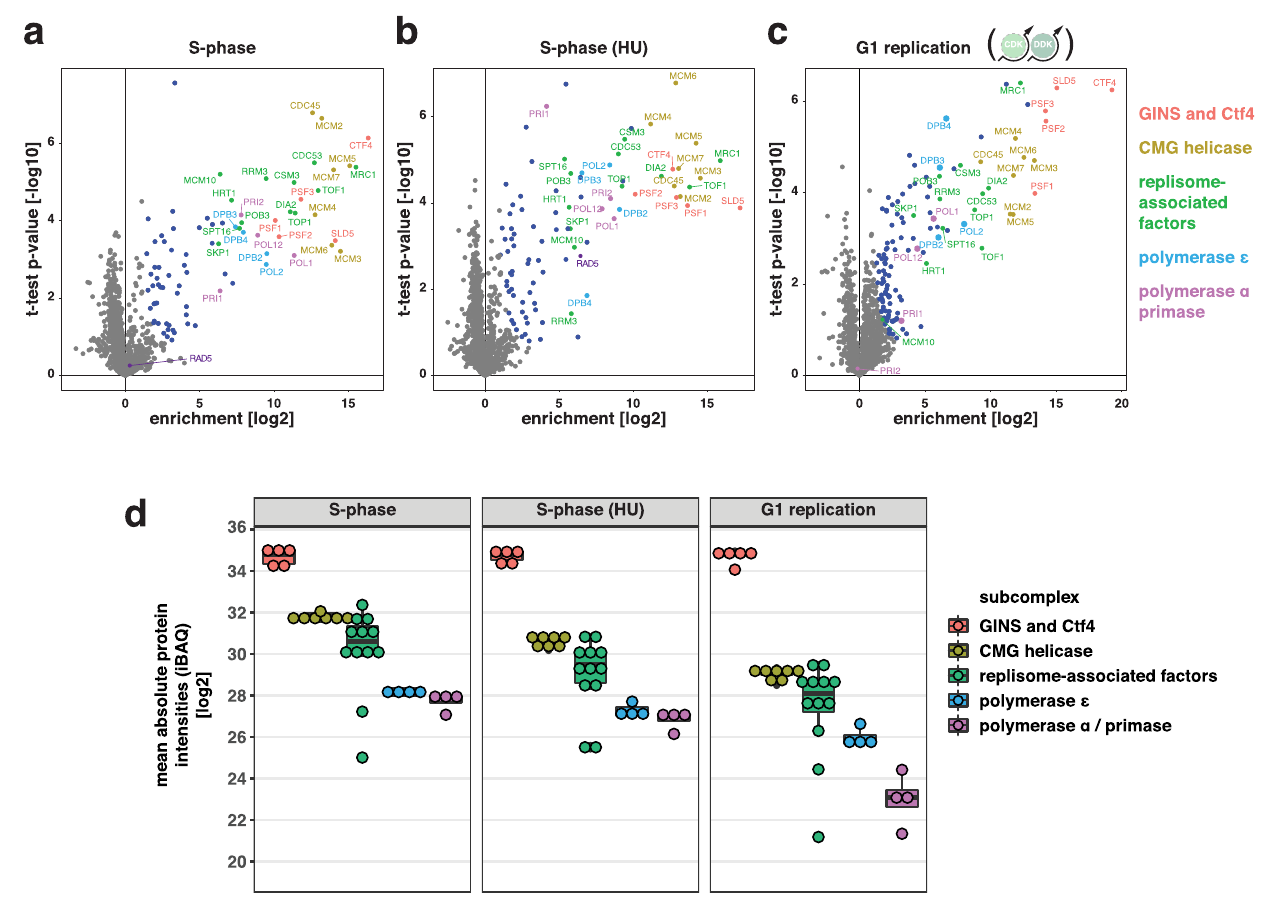
Fig.2|G1replisomesdifferquantitativelyinsubunitcompositionfromS-phase replisomes. a – c Replisomes in S- and G1-phase contain the same set of proteins. Cells were synchronously ( a ) released into S-phase, ( b ) arrested in S-phase using hydroxyurea (HU), or ( c ) G1 replication was induced for 3h using the CDK/DDK bypasssystem. Replisomes wereaf fi nity-puri fi ed viaGFP-taggedGINS-subunitPsf2 and analyzed by mass spectrometry. Volcano-plots show the enrichment of pro- teins in GFP-tagged samples versus untagged control samples. Colors indicate statistically signi fi cantly enriched proteins and replisome sub-complexes as